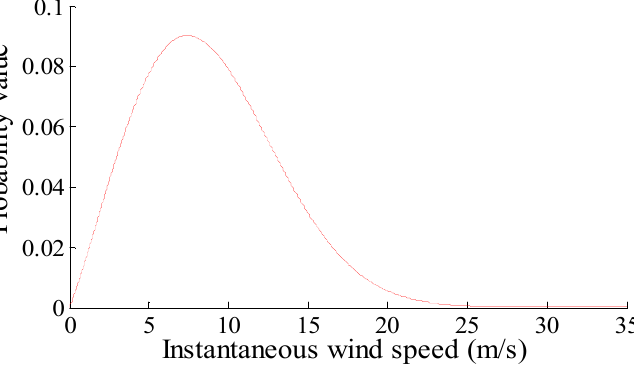
Figure 4. Distribution curve of instantaneous wind speeds.